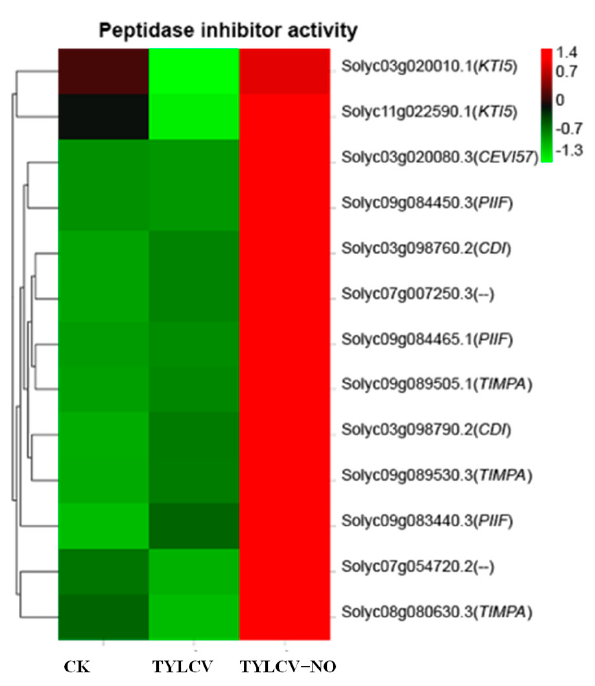
Figure 9. Effect of exogenous NO on peptidase inhibitor-related genes in diseased tomato, different colors indicate the expression level of each gene after normalization by